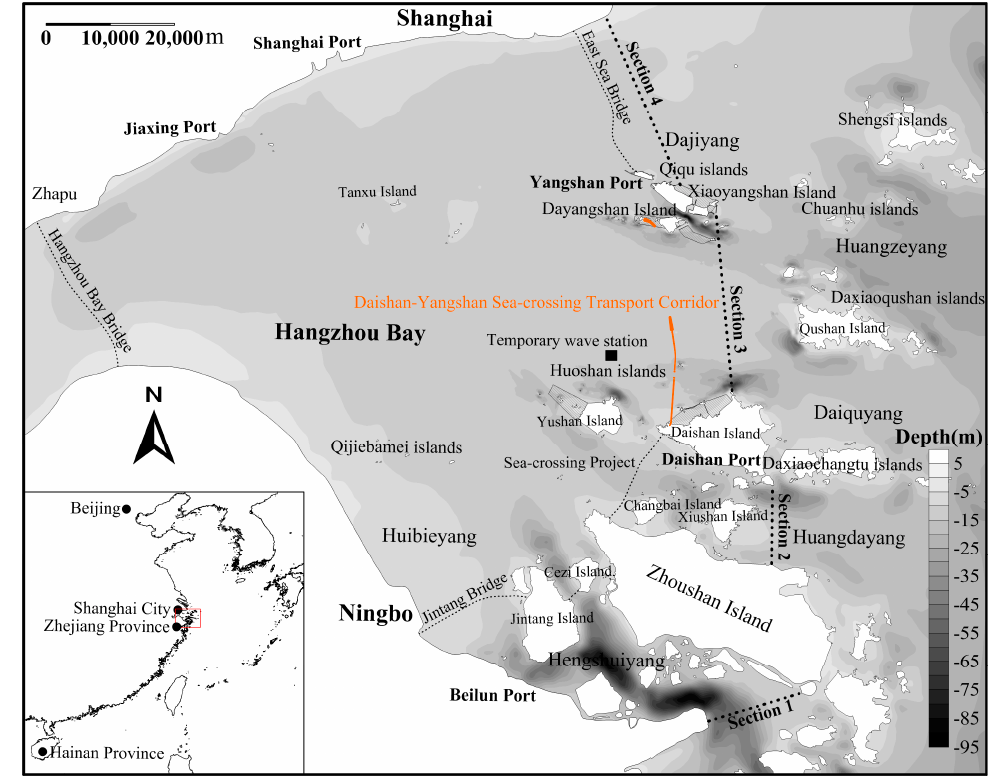
Figure 1. Location of the study area and tidal prism statistical sections (Section 1: Ningbo–Zhoushan Island, Section 2: Zhoushan Island − Daishan Island, Section 3: Daishan Island − Yangshan Island, Section 4: Yangshan Island − Shanghai).